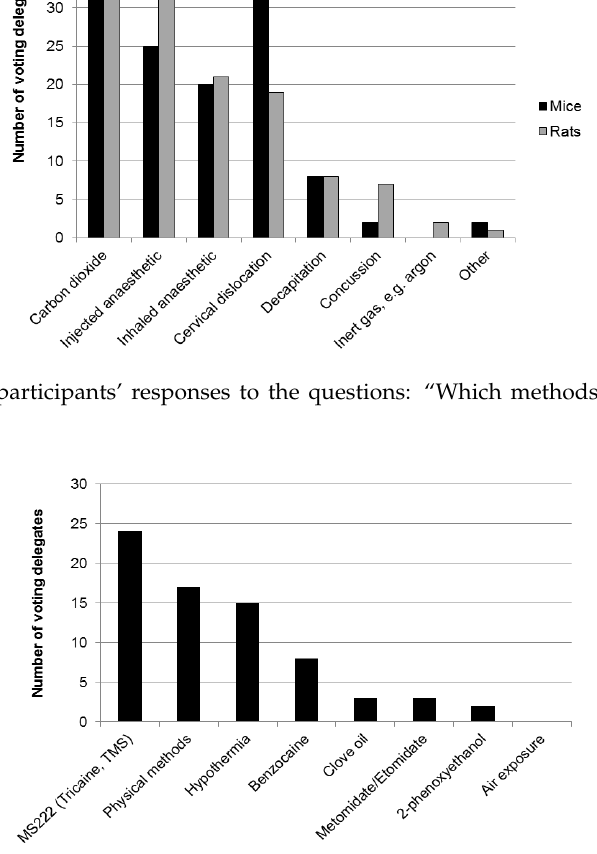
Figure 2. Meeting participants’ responses to the question: “Which methods do you use to kill fish?”.